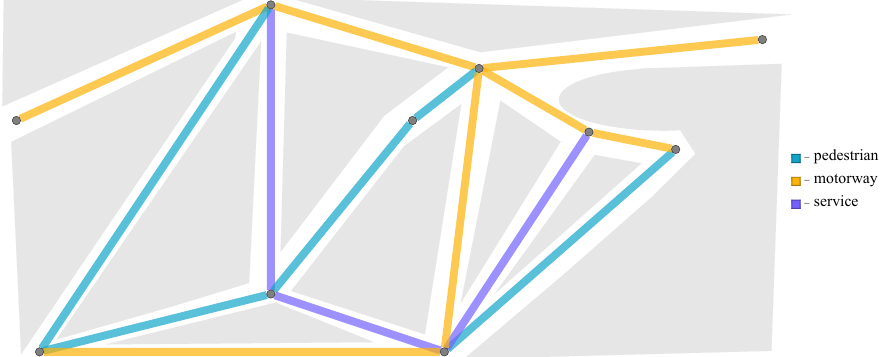
Figure 1. The primary graph G ( V , E ) for a street network.